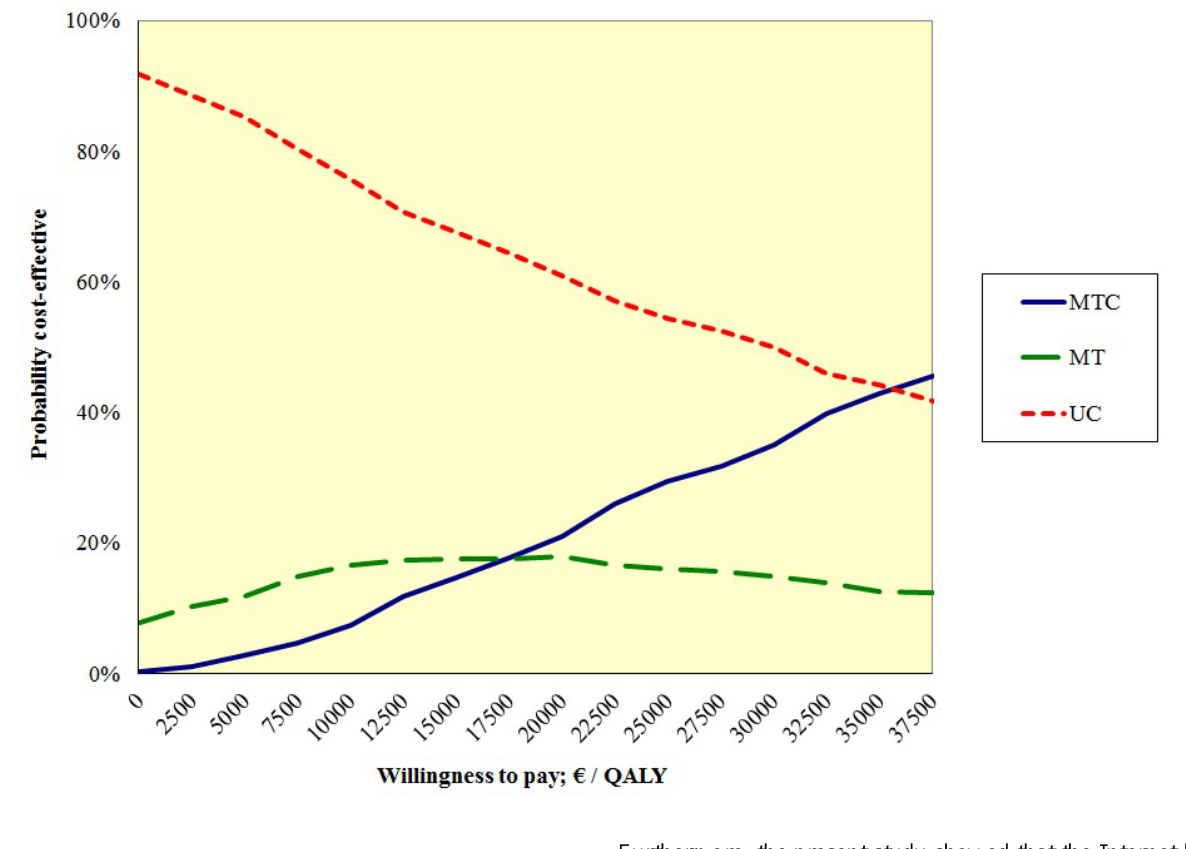
Figure 3. Cost-utility acceptability curve for the 3 treatments studied: MTC, MT, and